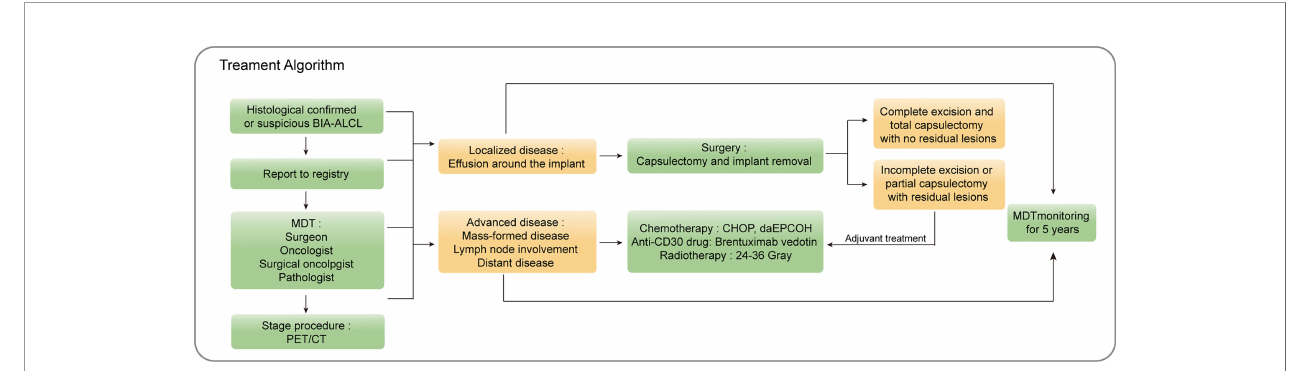
FIGURE 3 | Proposed treatment algorithm for BIA-ALCL. BIA-ALCL, breast implant-associated anaplastic large cell lymphoma; MDT; multidisciplinary team; CHOP, cyclophosphamide doxorubicin vincristine prednisolone; daE, dose adjusted